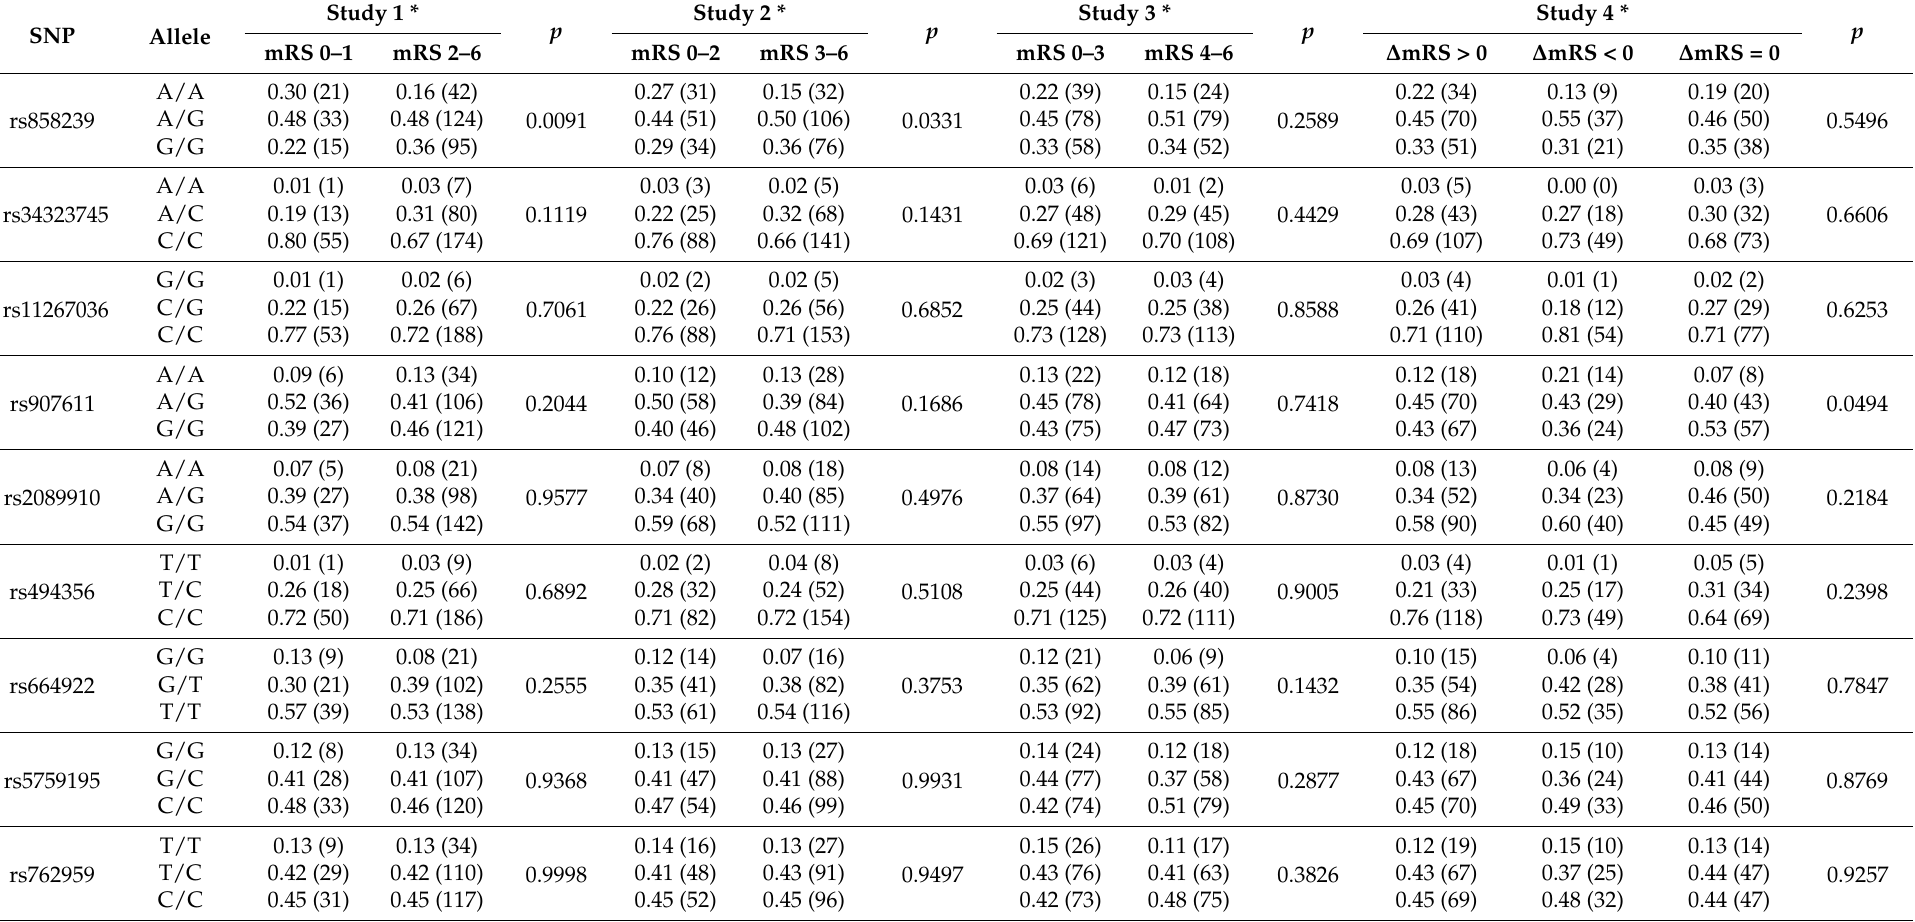
Table 1. Genotype frequency in the groups of patients from Studies 1, 2, 3, and